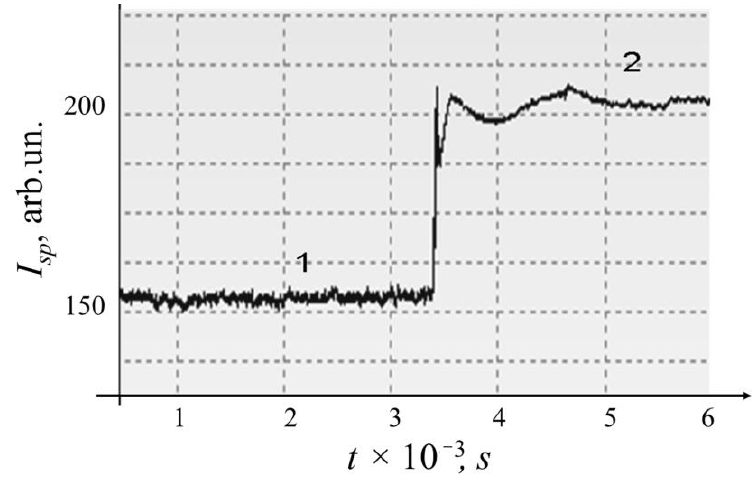
Figure 9. The change in intensity of fluctuations of I sp speckles for samples of E. coli M-17 No. 2 (1) and E. coli M-17 with ceftriaxone No. 7 (2).